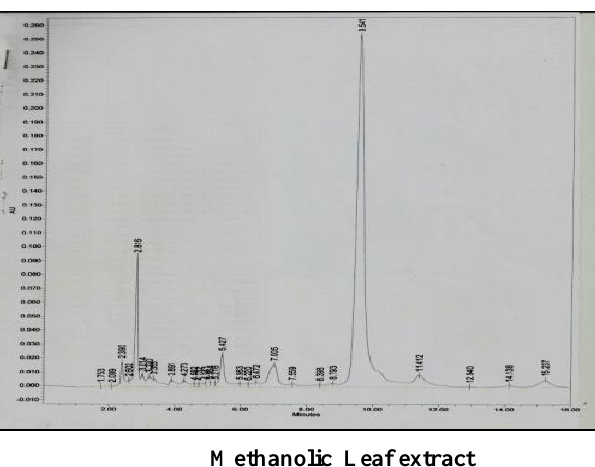
Figure 3: HPLC analysis of std. chlorogenic acid and methanolic extract of root & leaf sample. Table 3: The retention time of each isolated compound with that of reference standards